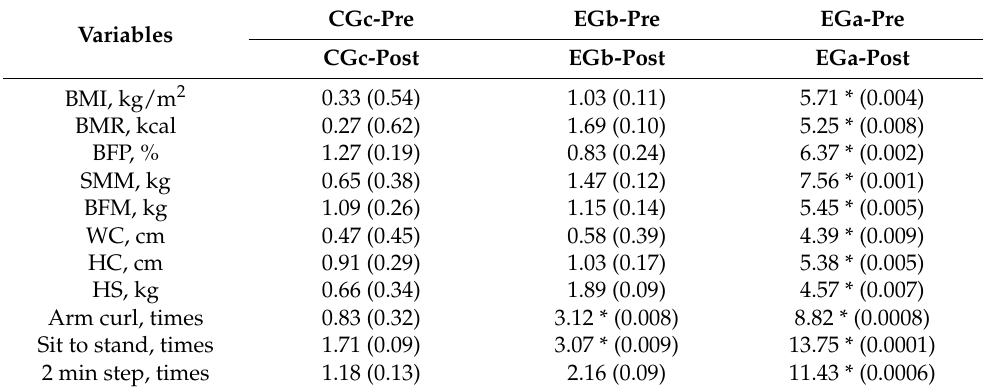
Table 5. Pre-test and post-test t-test results for all test items for the three study groups.